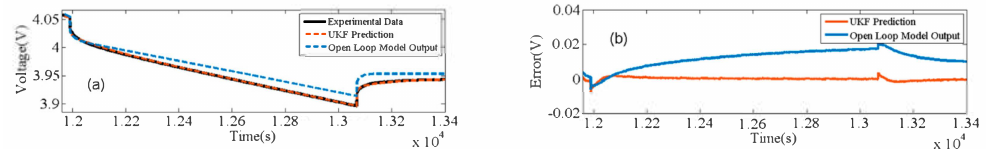
Figure 10. ( a ) The voltage comparison between experimental data, UKF prediction and open loop model output when SoC drops from 0.902 to 0.834. ( b ) The error comparison between UKF prediction and open loop model output when SoC drops from 0.902 to 0.834.